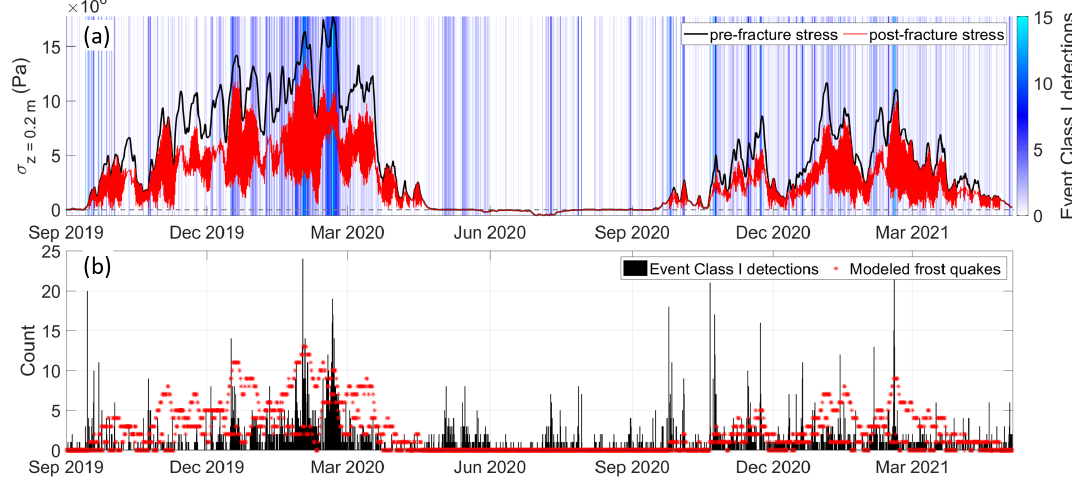
Figure 11. (a) Pre-fracture thermal stress (black) given by the solution to Eq. (12) and post-fracture thermal stress accounting for stress release by cracking (red) with a blue color gradient indicating the 6-hourly binned detection rate of class I events. (b) Modeled number of frost quakes (red) according to the fracture model (see Sect. 3.3.1) and a 6-hourly binned frequency histogram of class I events